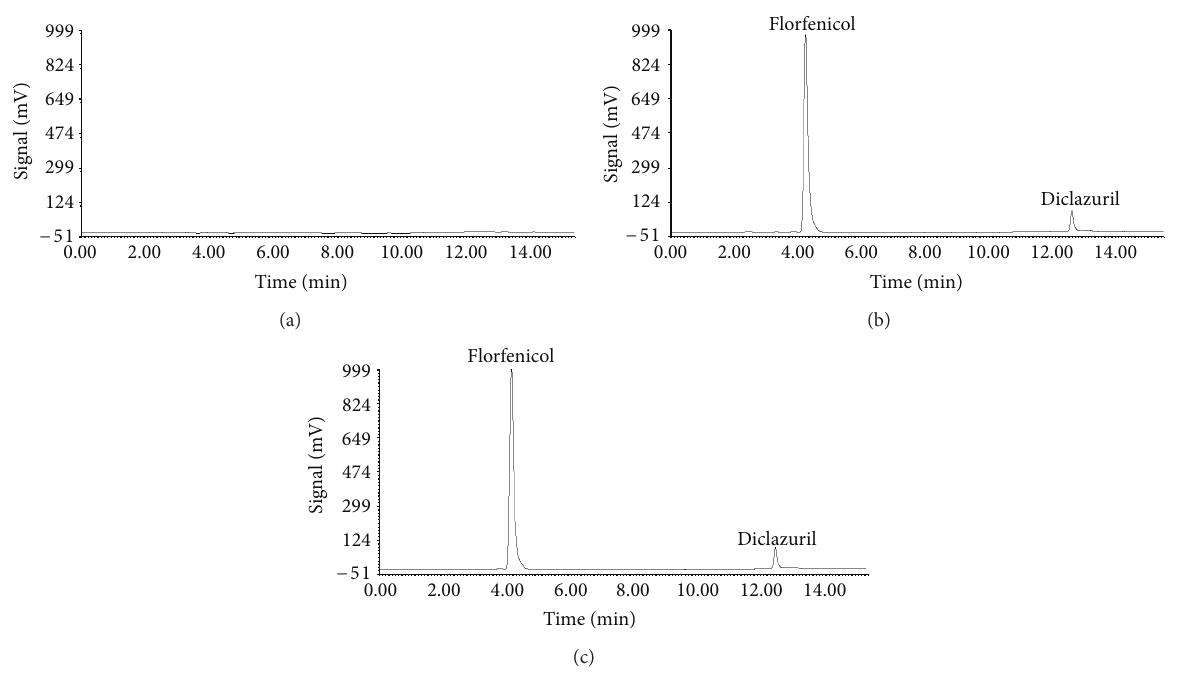
Figure 2: Typical HPLC chromatograms of (a) blank excipients sample, (b) compound powder sample with florfenicol and diclazuril (c) standard solutions sample with florfenicol (200.0 𝜇 g/mL) and diclazuril (20.0 𝜇